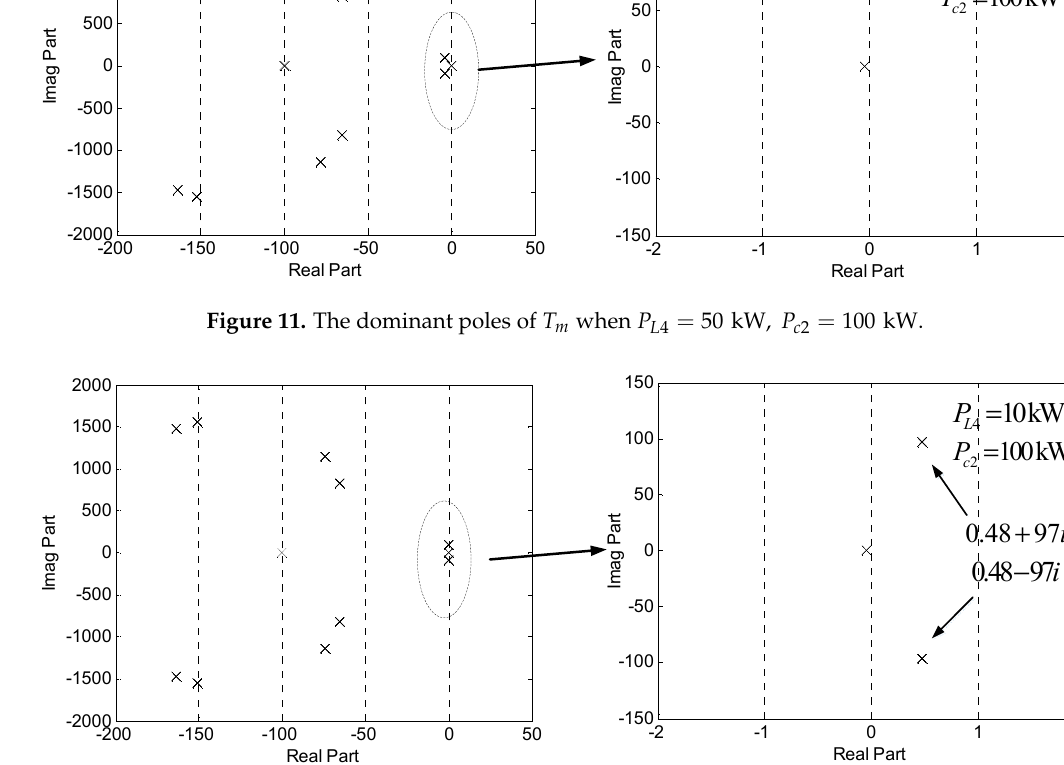
Figure 12. The dominant poles of T m when P L 4 = 10 kW, P c 2 = 100